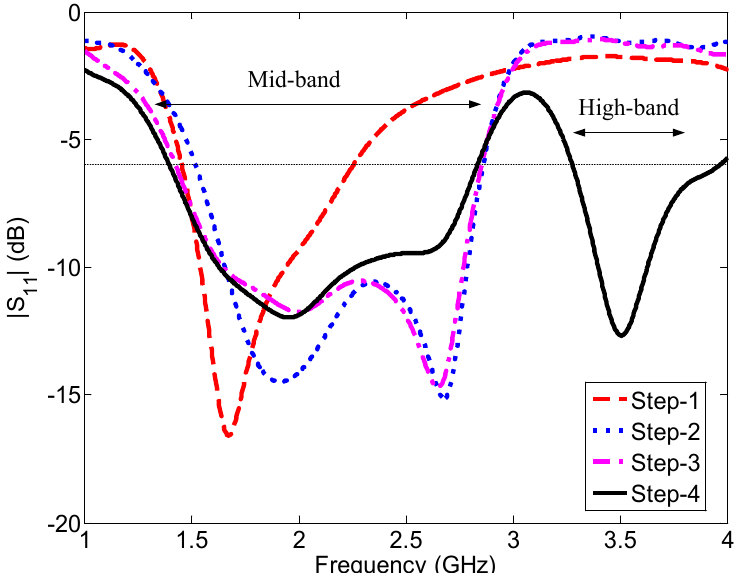
Figure 8. Reflection coefficient for each step in the dual-band antenna (Ant#2)